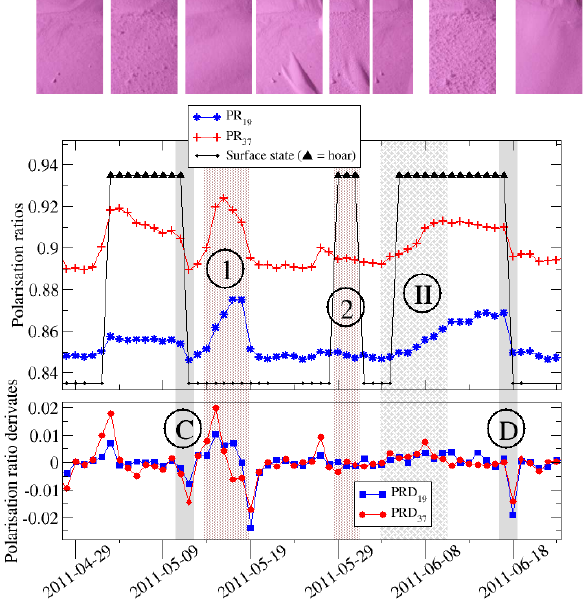
Fig. 7. Evolution of the surface state at Dome C (unscaled black symbols and small pictures above the graph), and time series of po- Fig. 7 : Evolution of the surface state at Dome C (Unscaled black symbols and small pictures Fig. 8. Evolution of the surface state at Dome C (unscaled black Fig. 8 : Evolution of the surface state at Dome C (Unscaled black symbols and small pictures larisation ratios at 19 and 37GHz and their derivatives (respectively above the graph), and time series of polarisation ratios at 19 and 37 GHz and their derivatives symbols and small pictures above the graph), and time series of po- above the graph), and time series of polarisation ratios at 19 and 37 GHz and their derivatives PRD 19 and PRD 37 ), in December 2009 and January 2010. (A) and (respectively PRD 19 and PRD 37 ), in December 2009 and January 2010. (A) and (B) mark two larisation ratios at 19 and 37GHz and their derivatives (respectively (respectively PRD 19 and PRD 37 ), in May and June 2011. (C) and (D) mark two events of hoar (B) mark two events of hoar crystal disappearance, and (I) a period events of hoar crystal disappearance, and (I) a period of hoar crystal development. PRD 19 and PRD 37 ), in May and June 2011. (C) and (D) mark two crystal disappearance, (II) is a period of hoar crystal development, and (1) and (2) are two short of hoar crystal development. events of hoar crystal disappearance, (II) is a period of hoar crystal periods without correlation between surface state and polarisation ratios. development, and (1) and (2) are two short periods without correla- tion between surface state and polarisation